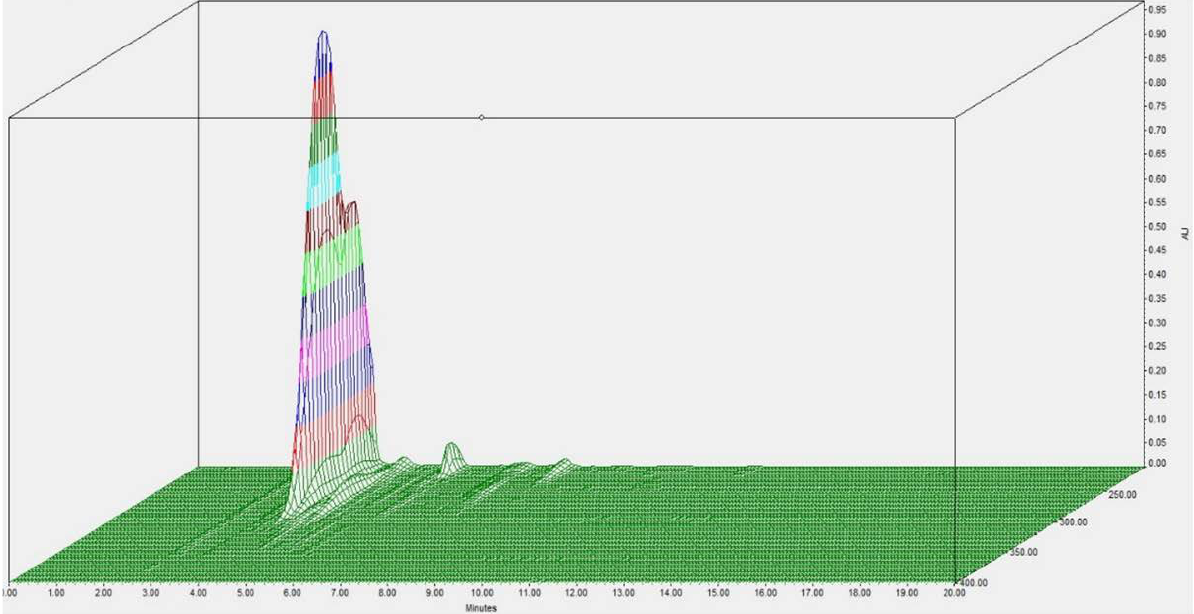
Figure 3. Three − dimensional chromatogram of agave fructan bioconjugates with laurate showing the variety of products due to agave fructan ramification.